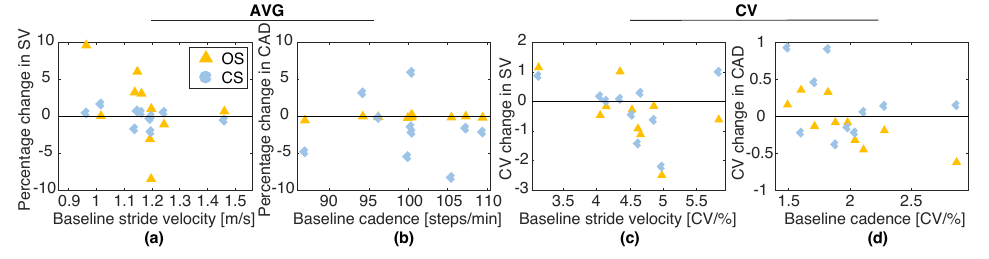
Figure 7. ( a , b ) Percentage changes in SV and CAD (relative to their baseline values SV P and CAD P ) induced by the two stimulation modes during S1, as functions of the baseline values; ( c , d ) Changes in the coefficients of variation ( CV ) of SV and CAD induced by the two stimulation methods during S1, as functions of the baseline CV . In all plots, each mark represents a participant.